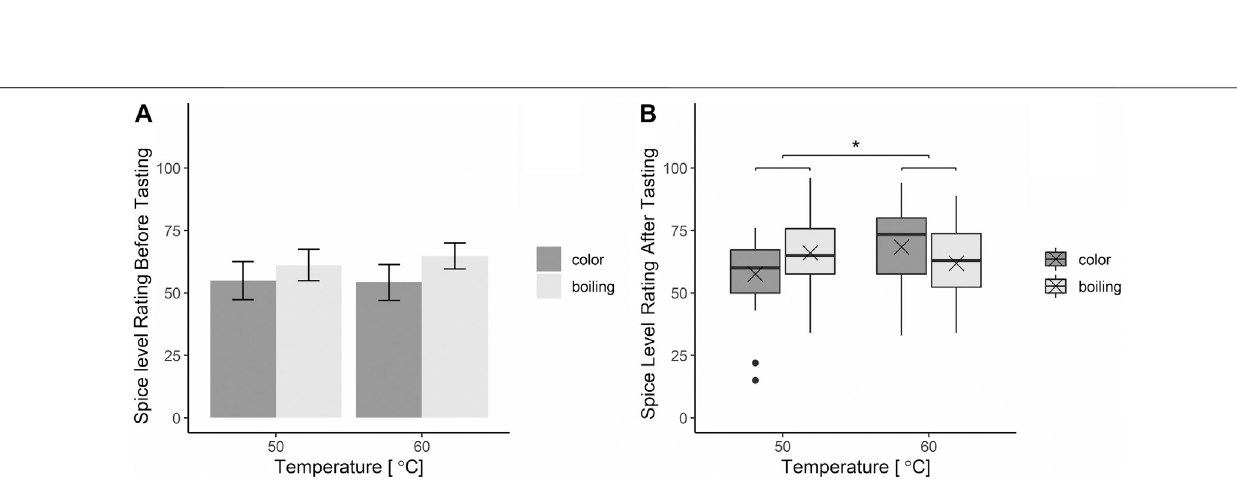
FIGURE 4 | (A) Spice level ratings before tasting and (B) after